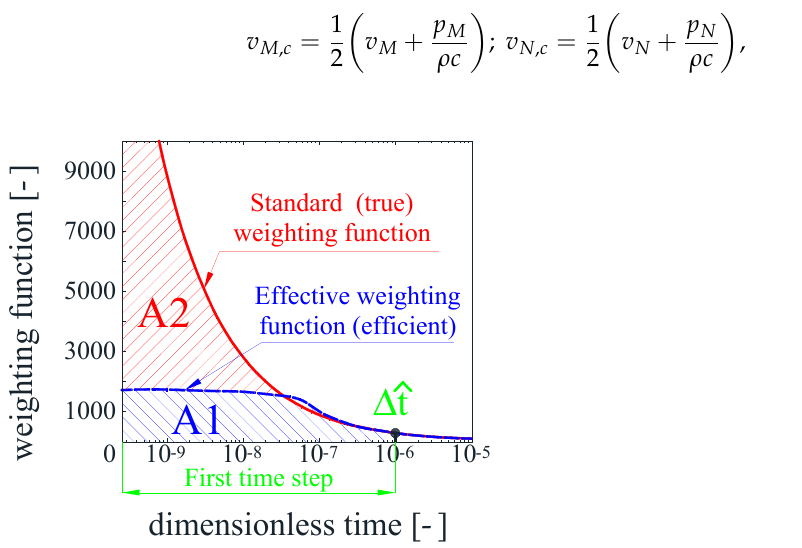
Figure 3. Areas under classic and efficient weighting function for low dimensionless times.